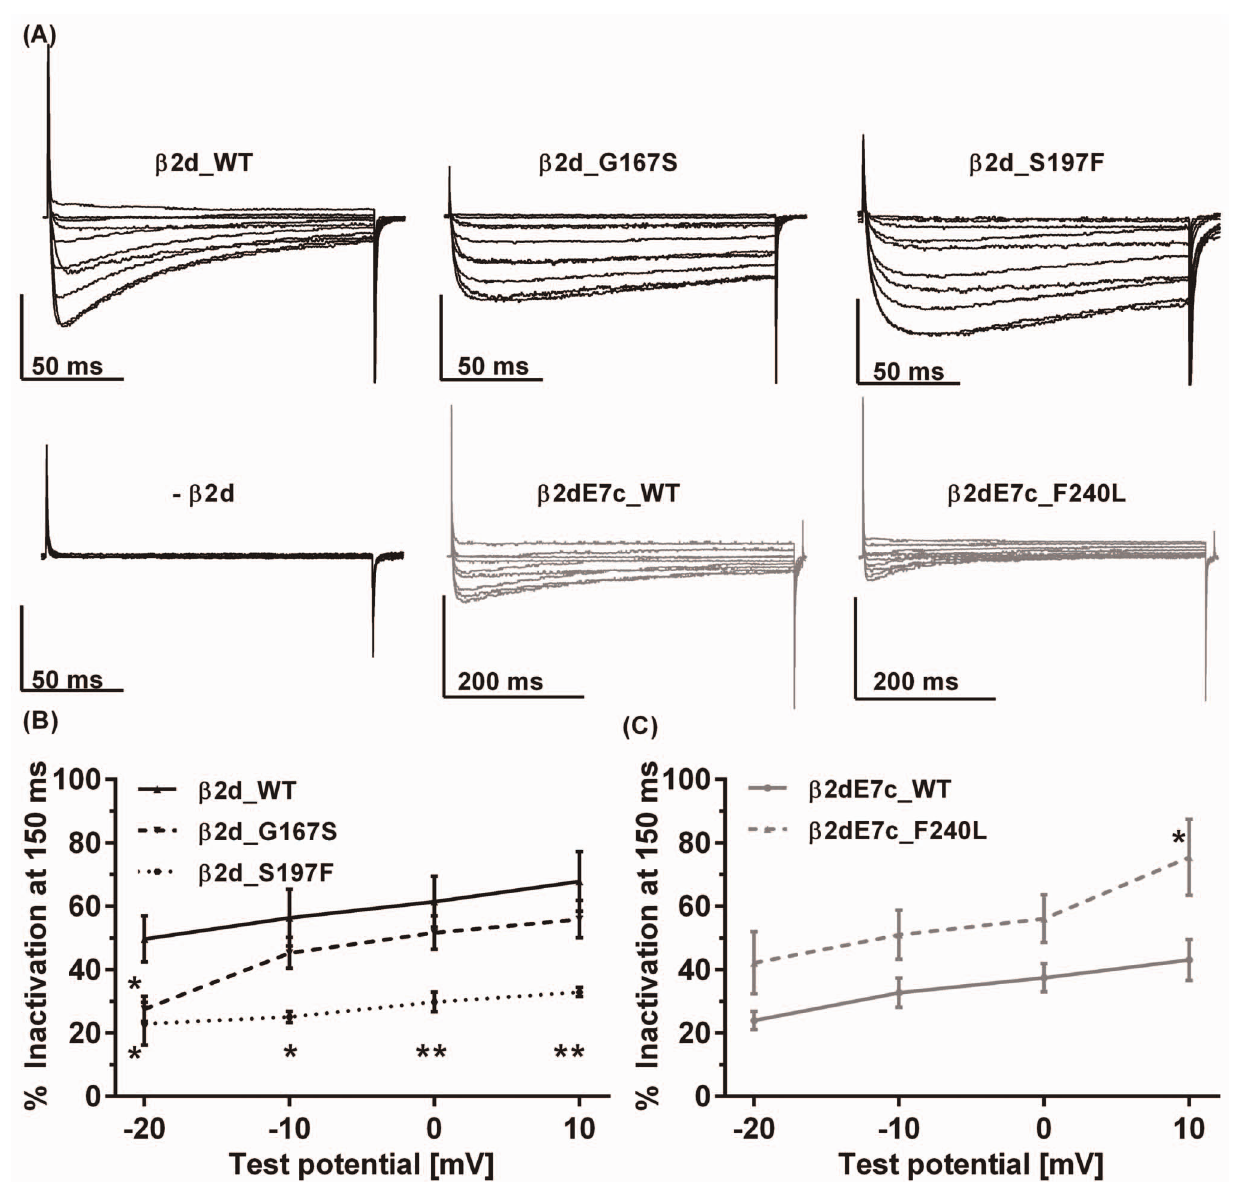
Figure 5. Time-dependent inactivation. Representative whole-cell Ba 2 + current traces (a) of Ca V 1.2/ a 2 d 1 co-expressed with b 2d_WT -subunit or co-expressed with the ASD mutants b 2d_G167S, b 2d_S197F or the b 2dE7c_WT or its variant b 2dE7c_F240L. The currents were elicited from a holding potential of 2 100 mV by 150 ms (or 500ms) step depolarization of 2 40 to + 50 mV with 20 mM Ba 2 + (for b 2d variants) or 5 mM Ba 2 + (for b 2dE7c variants), respectively. Analysis of the extent of time-dependent inactivation. ( b , c ) % Inactivation was analyzed as the remaining fraction of whole- cell current that has not inactivated after 150 ms of depolarization. b 2d_WT (N=12), b 2d_G167S (N=8), b 2d_S197F (N=11) ( c ) Similar analysis for b 2dE7c variants b 2dE7c_WT (N=5), b 2dE7c_F240L (N=6). Asterisk (*) marks a statistical significance (P , 0.05) compared to the respective WT, (**) marks P , 0.01.